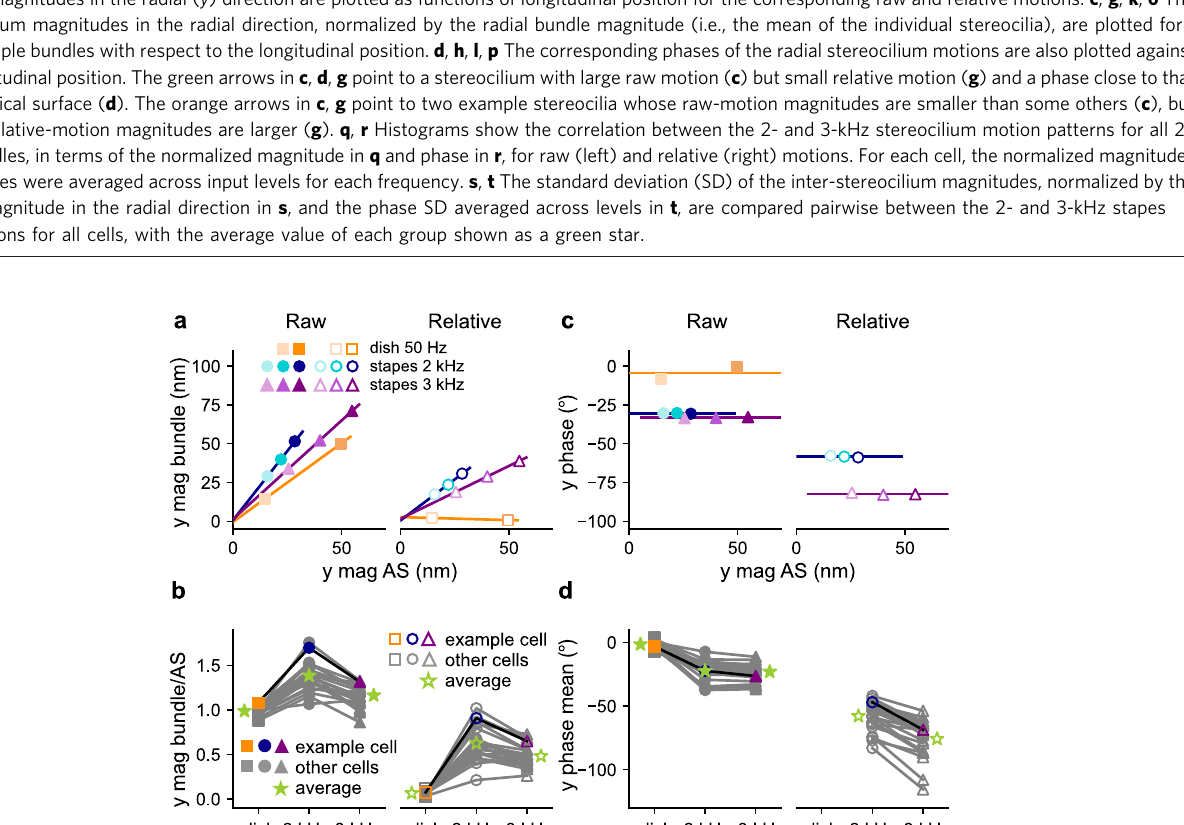
Fig. 4 Bundle vs. apical-surface motion. The bundle motion is de fi ned as the average motion of the tallest-row stereocilia within a bundle, as measured near the upper tips of the stereocilia. a The radial ( y ) bundle magnitudes are plotted against the radial apical-surface (AS) magnitude for an example bundle. In a – d , the raw bundle motion is shown on the left and the relative bundle motion is shown on the right. b The ratios of the bundle magnitude and the corresponding AS magnitude in the radial direction are compared among the three stimulation conditions (50-Hz dish, 2-kHz stapes, and 3-kHz stapes) for all bundles, with the average value of each group shown as a green star. c For the example bundle, the radial bundle phase is plotted against the radial AS magnitude, with the bundle phase calculated relative to the AS motion in each case. In c , d , the phases of the relative motion for dish stimulation are omitted because the relative motion of the bundle is so small that the con fi dence in the phase measurement is low. d The mean radial bundle phase (across input levels) is compared among the three stimulation conditions for all bundles, with the average value of each group shown as a green